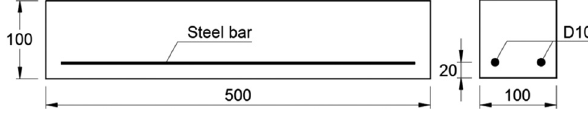
Table 1: Mixture proportion for 1 m 3 of concrete ( unit: kg )